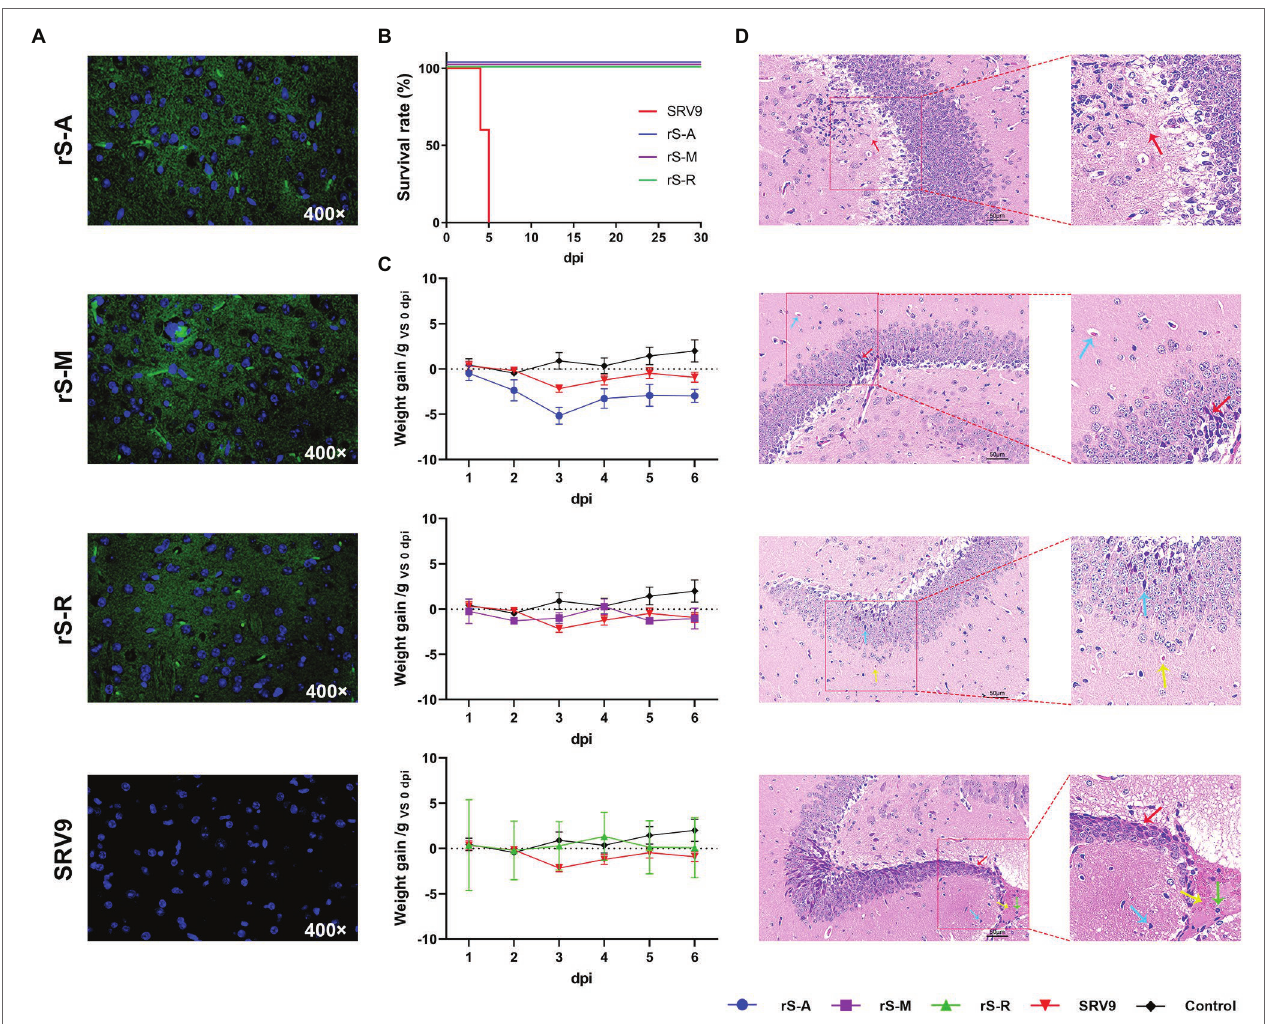
FIGURE 6 | Safety Evaluation of Pseudovirus (A) After intracranial inoculation of pseudovirus in adult mice, the proliferation and replication of the virus in the mouse brain were observed by fluorescence microscope. Pseudoviruses carrying fluorescent properties can infect the brain tissue of adult mice and replicate and proliferate generally in the brain. Green fluorescence can be directly observed in brain slices under a fluorescence microscope, but the parental virus does not possess this property. (B) Survival curve of 3-day-old ICR suckling mice after intracranial inoculation with pseudovirus. The parental virus SRV9 group (n = 5) started to die on the fourth day, and the survival rate decreased to 0% on the fifth day. The three pseudoviruses obtained by manipulating the parental virus showed high safety, which is reflected in the fact that under the same conditions, all the suckling mice inoculated with the three pseudoviruses survived until the end of the experimental observation period (30 days). (C) Bodyweight changes after intracranial inoculation of pseudovirus in adult mice. The figure shows the change in the experimental and control groups’ body weight during the observation period after inoculation compared with that before inoculation. All experimental group data were compared with the PBS control group, with 0 as the fluctuating baseline (dashed line), and there was a significant difference between rS-A and PBS ( p = 0.0032). (D) Histopathological analysis of adult mouse brain after inoculation with pseudovirus. Adult mice were randomly selected after intracranial inoculation with pseudovirus on the seventh day. The brain tissue was fixed with 4% paraformaldehyde, and the vicinity of the hippocampal formation was selected for analysis. Arrows indicate local lesions in sections of brain samples, and the color of the arrows distinguishes the different pathological changes shown within each